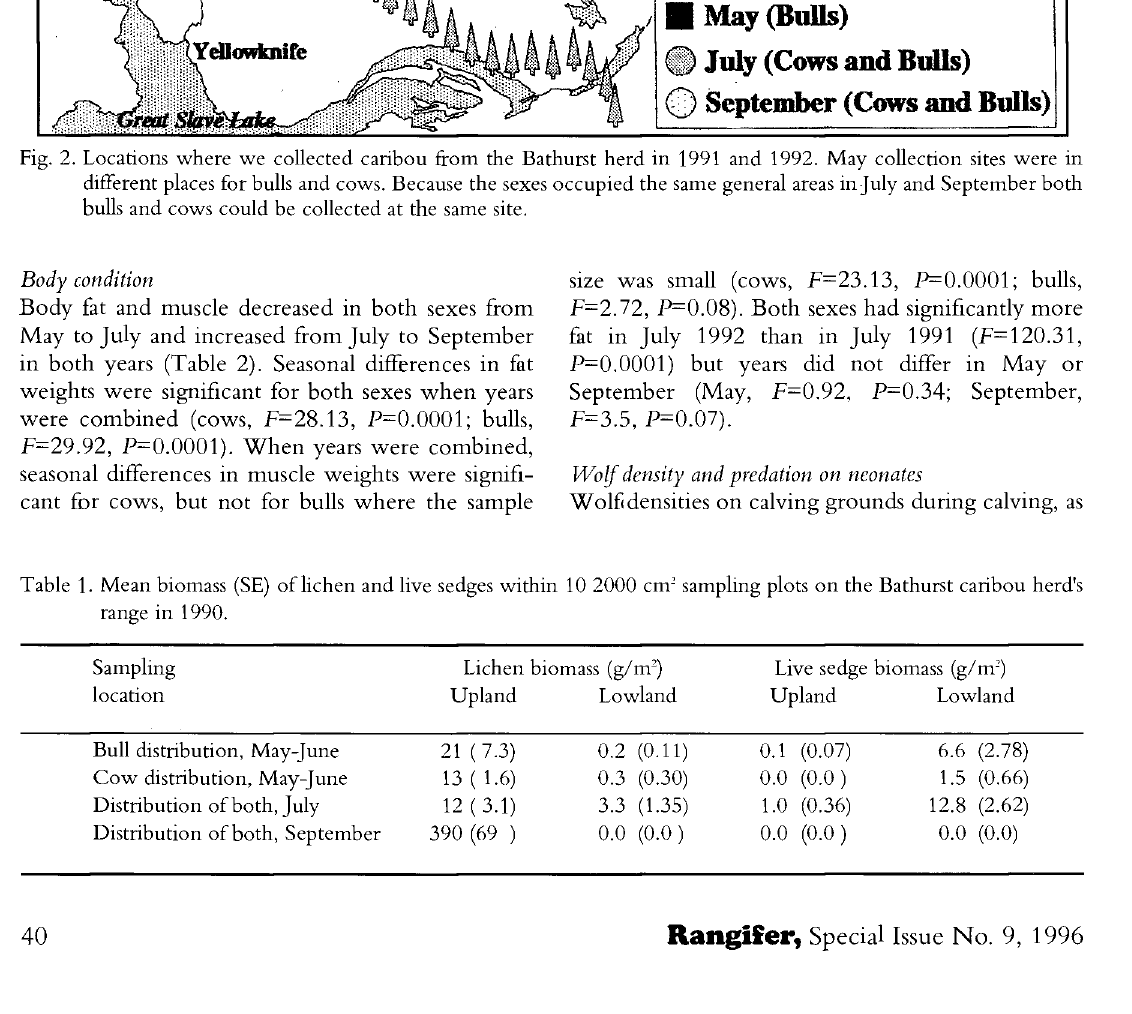
Table 1. Mean biomass (SE) of lichen and live sedges within 10 2000 cm- sampling plots on the Bathurst caribou herd's range in